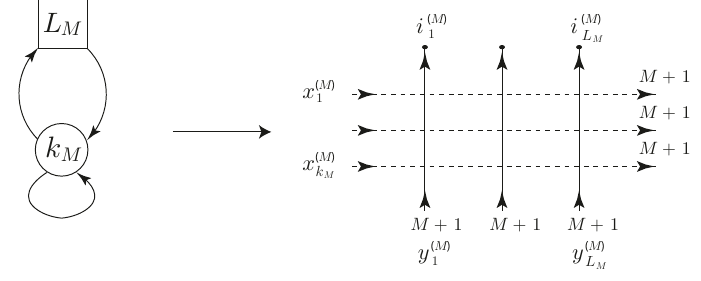
Figure 14 . A lattice configuration associated with the M -th